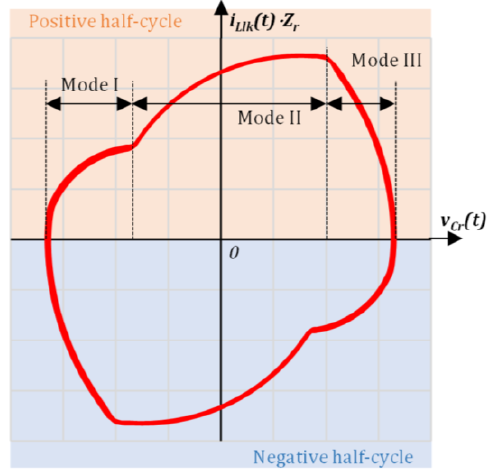
Figure 3. Sketch of the state-plane trajectory of the resonant tank with the overlapping PWM scheme for the abnormal operating conditions when ∆𝑉 𝐶𝑟 > 2𝑛𝑉 𝐼𝑁 .